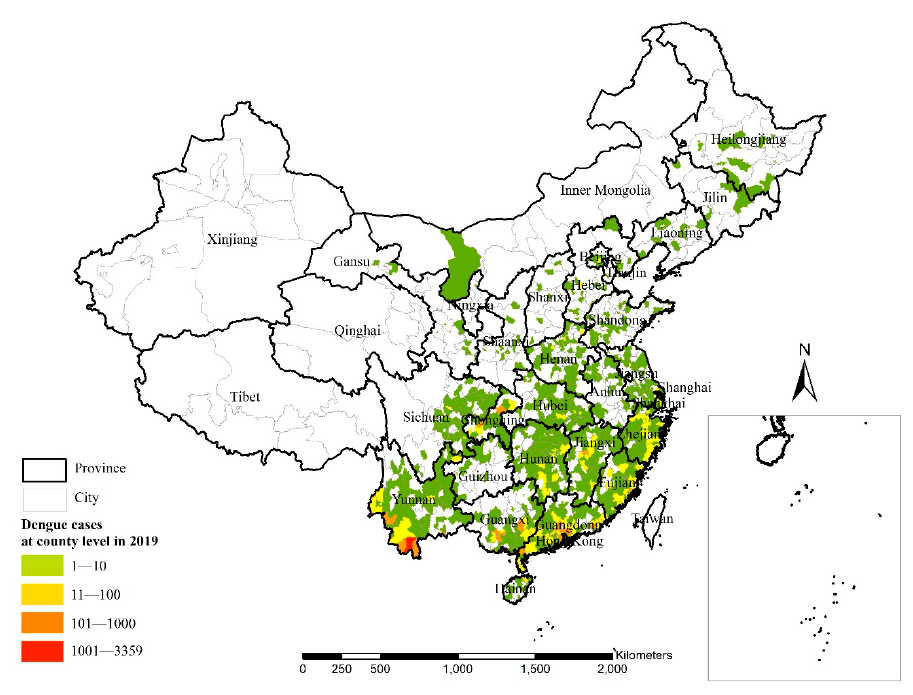
Figure 1. Spatial distribution of dengue cases in mainland China in 2019.